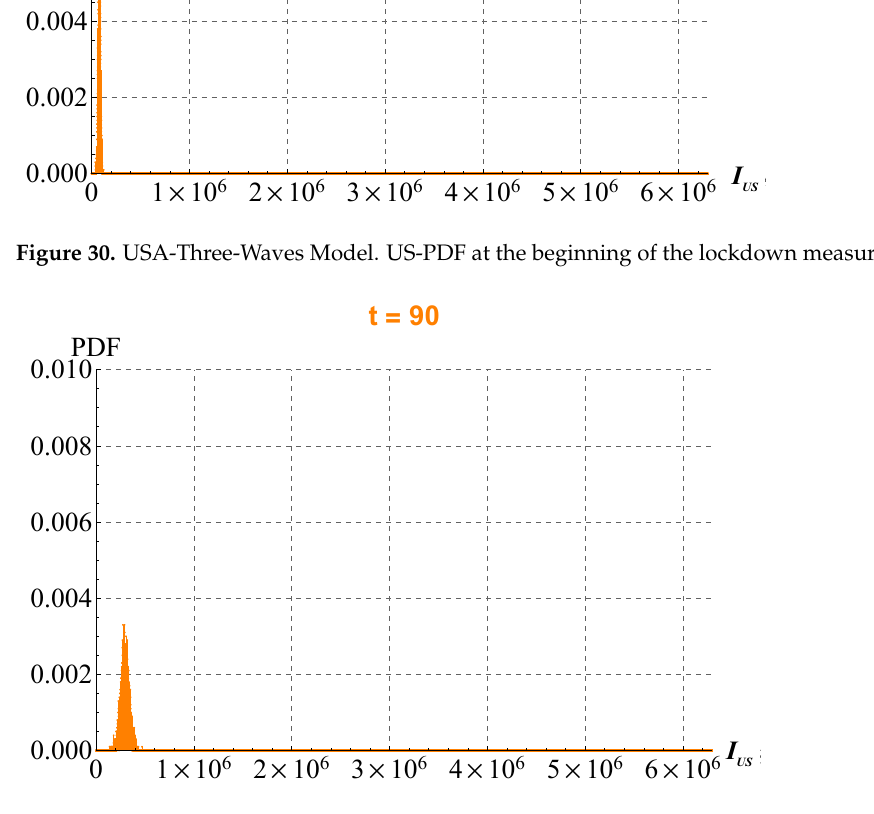
Figure 31. USA-Three-Waves Model. US-PDF after 90 days.